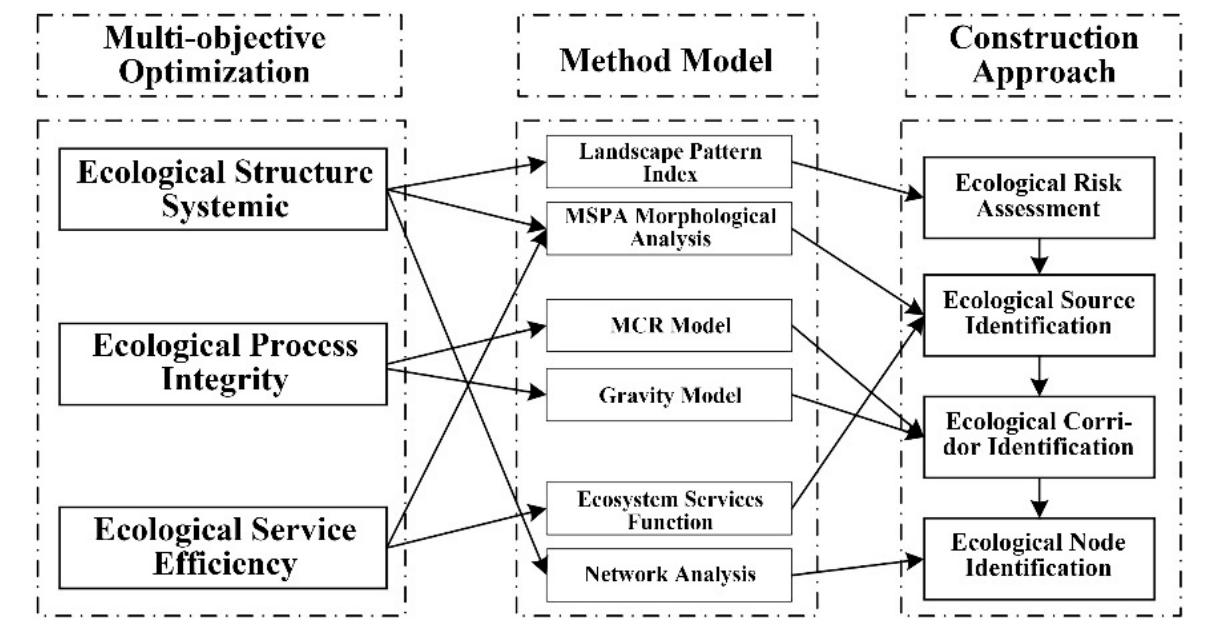
Figure 3. Ecological network construction approach of the life community of mountains–rivers–forests–farmlands–lakes–grasslands under the guidance of multi-objective optimization.